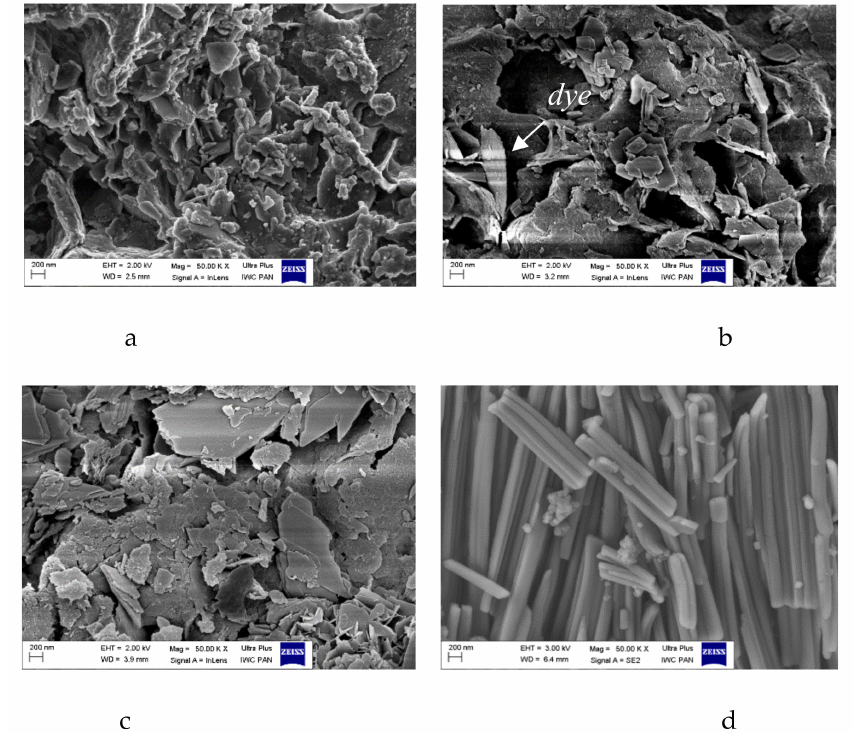
Figure 6. SEM micrographs of AlMg − LH ( a ), AlMg − LH/AD 10% ( b ), AlMg − LH/AD 20% ( c ), and AD ( d ).